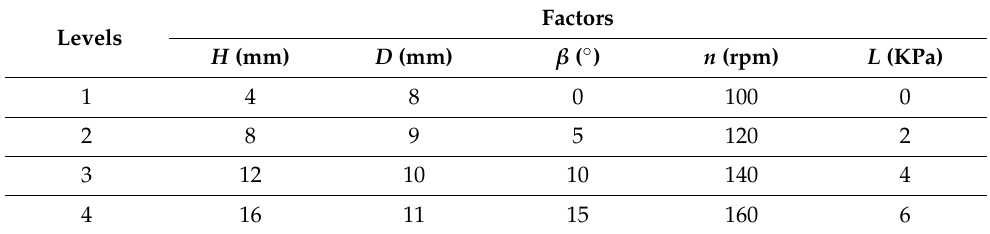
Table 2. Factors and levels in orthogonal test.